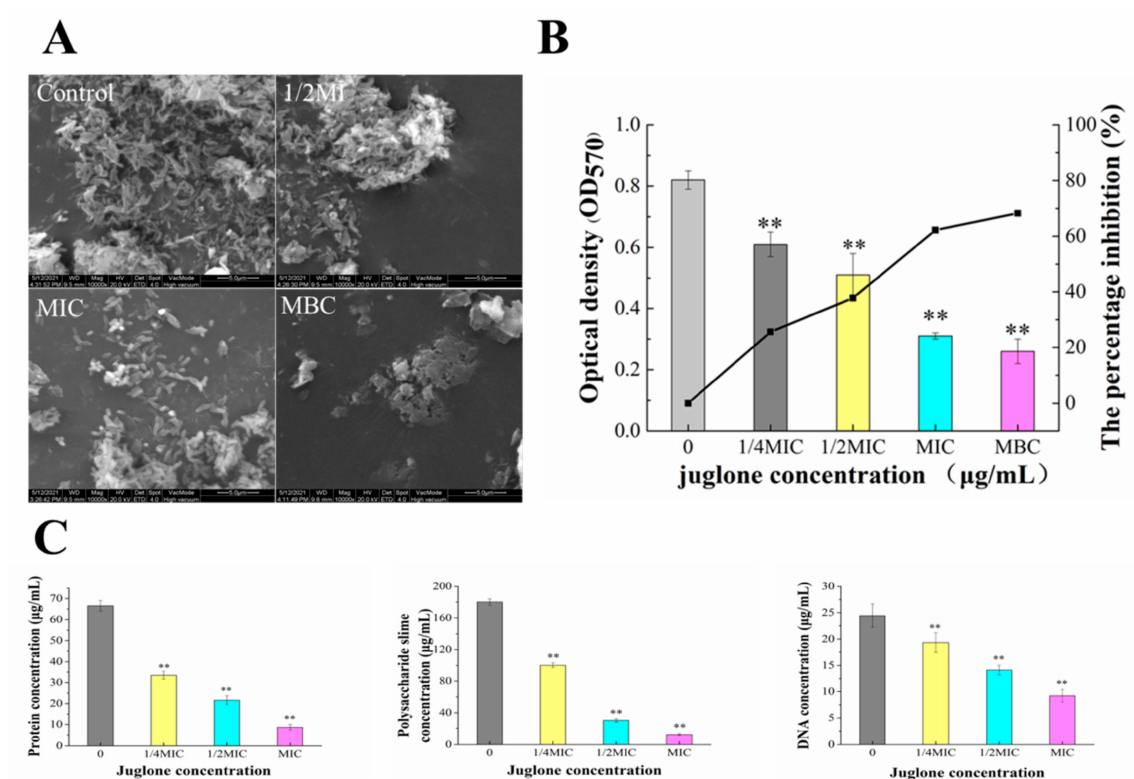
Figure 7. ESEM images of the effects of juglone on P. syringae biofilm formation ( A ). Crystal violet quantitative assay displayed the effect of juglone against P. syringae formation ( B ). C represents protein, polysaccharide mucus and DNA contents in EPS, respectively ( C ) (Each bar represents the mean ± SD of three independent experiments, ** p < 0.01 versus the control